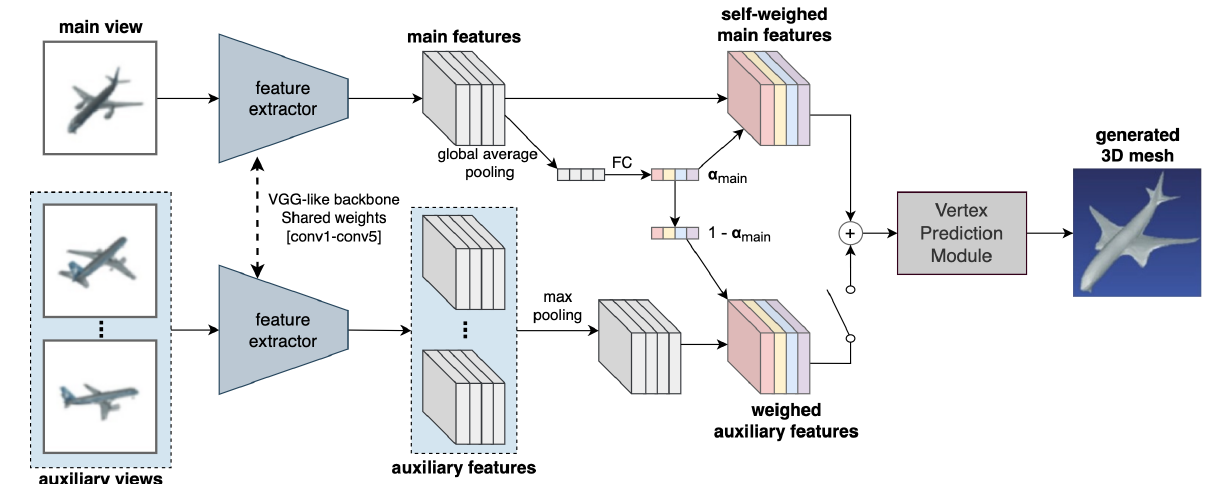
Figure 9. Overview of VANet [9], a unified approach for both single and multi-view reconstruction with a two-branch architecture.